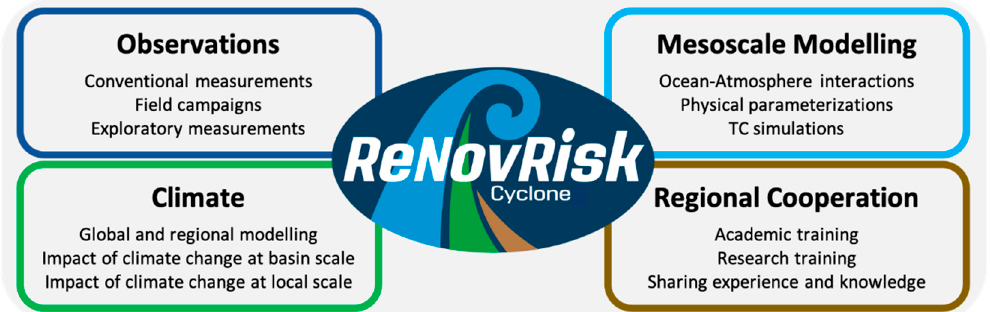
Figure 2. Structure and main objectives of ReNovRisk-CYCLONE.